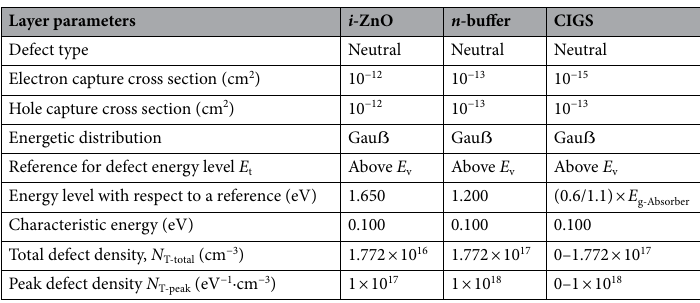
Table 3. Defect characteristics of all layers employed in this